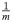
ABC plots for selected common distributions.For comparison, the ABC plots for the uniform distribution, U = Uniform [0,m], where the data points x are drawn with uniform probability 1m within the interval from 0 to a maximum of m, and for the identity distribution i.e., all x
i have the same value x
i = c, are shown as green and magenta lines, respectively. Left upper panel: ABC plot of the Lognormal distribution LN(m,s) with s = 3. The ABC curve for LN(m,s) is independent of m. Upper right panel: ABC plot of the family of exponential distributions with cdf = 1 – e
λx. The ABC curve for these distributions depends on the value of λ. Lower left panel: ABC plot of a Pareto distribution with =1-(xminx)α. For α = 1.18 the ABC curve passes through the “Pareto” point (see last paragraph of the discussion) at 20/80%). Lower right panel: ABC plot of a Gaussian distribution N(5,1). This distribution shows lower inequality than the uniform distribution (green line) and comes close to the identity distribution (magenta line).